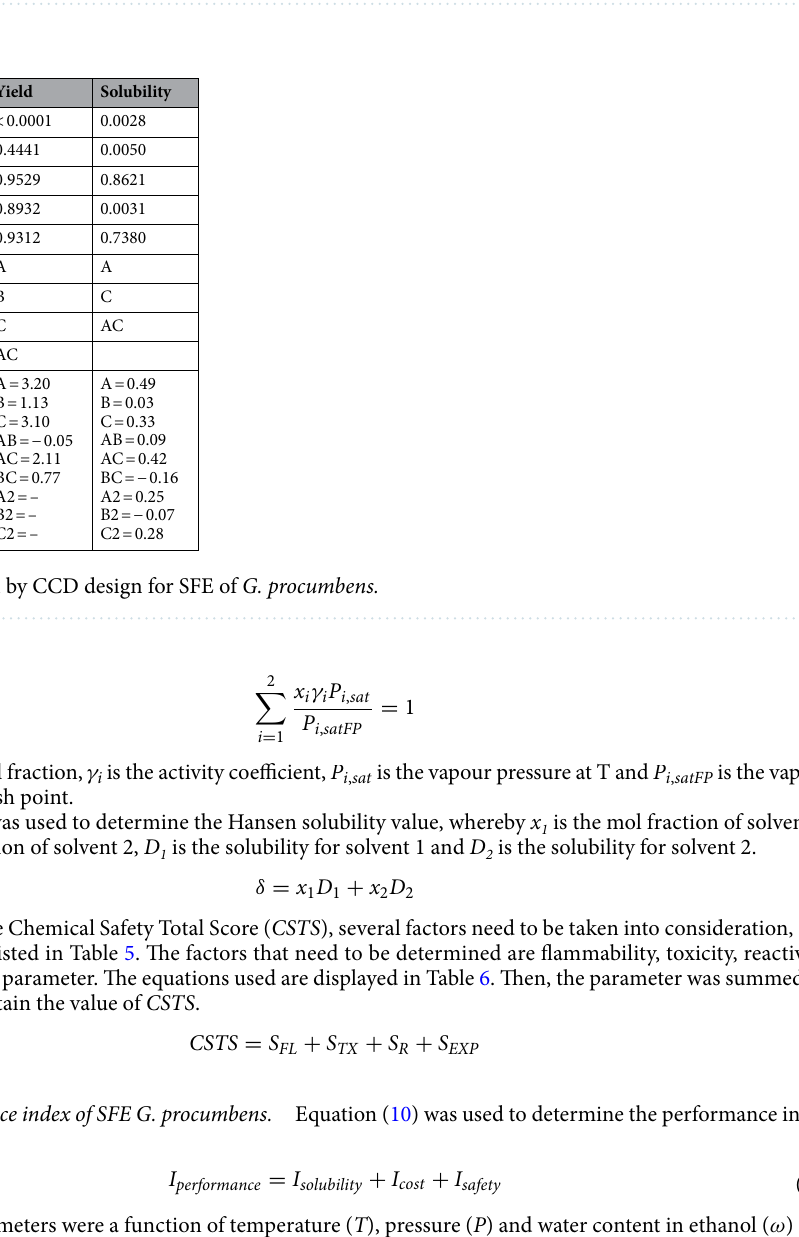
Table 5. Logistic function for determining the parameter for each factor.